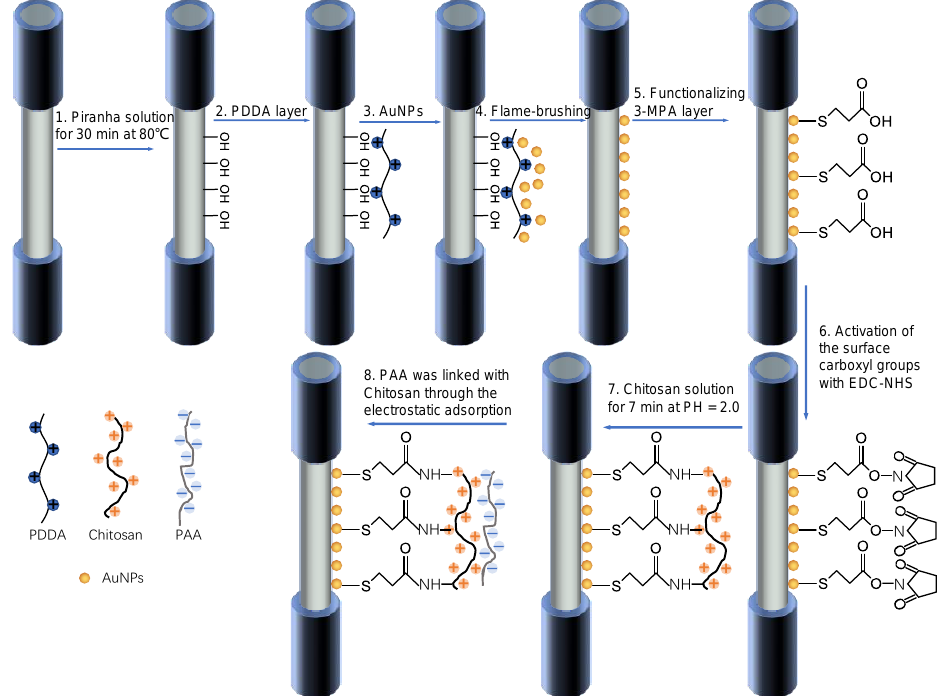
Figure 1. Schematic of the processes involved in the optical localized surface plasmon resonance (LSPR) sensor preparation.